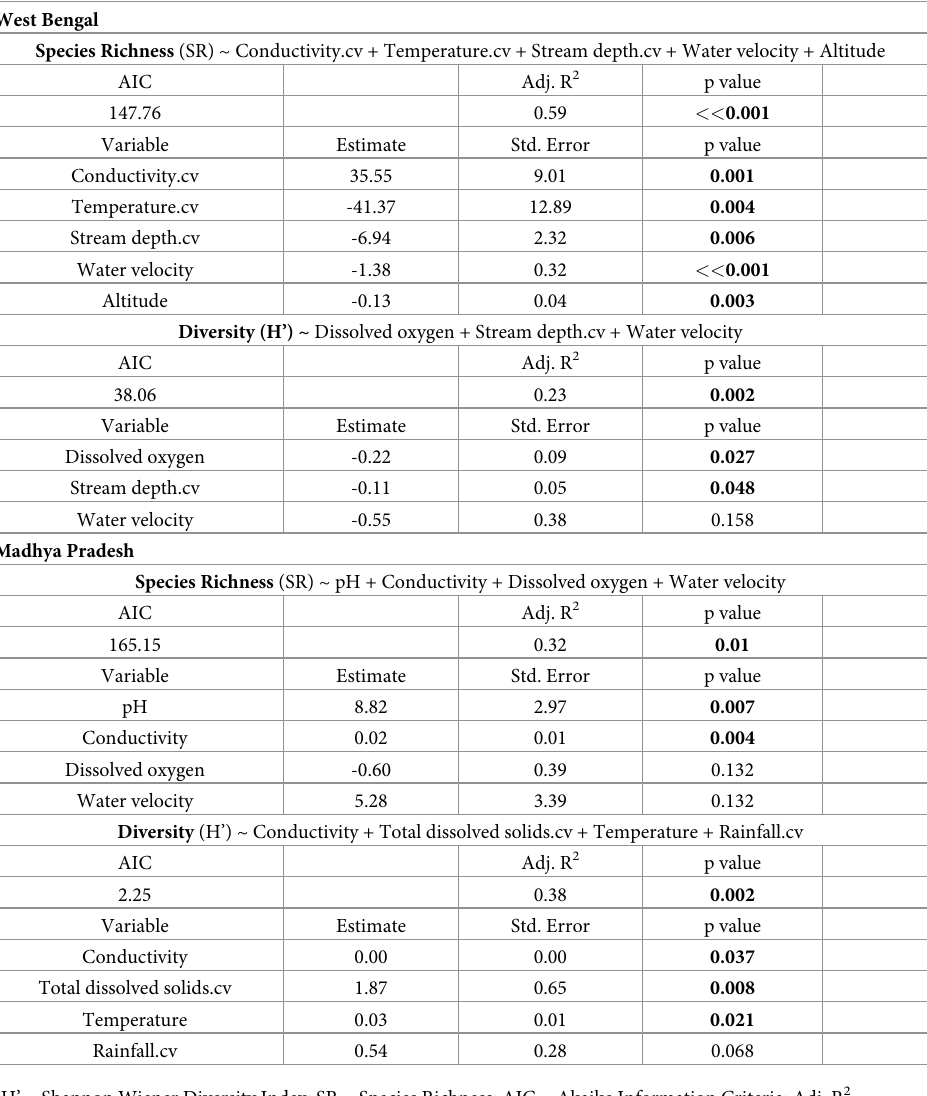
Table 6. Summary of final models chosen for explaining Species Richness (SR) and Shannon diversity (H’) for both study regions. Significant factors, i.e. p � 0.05 are shown in